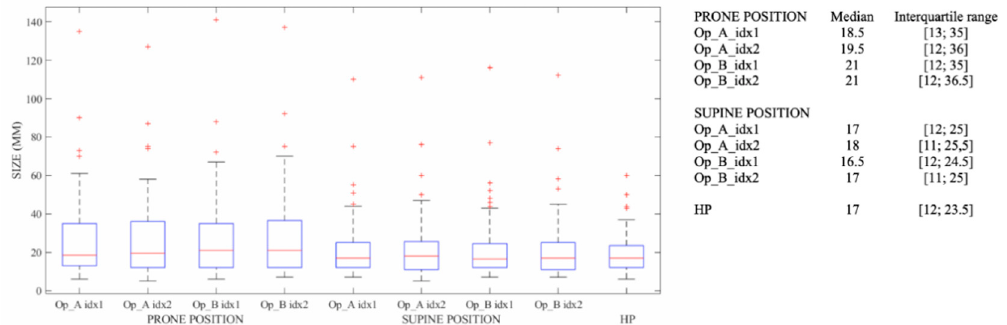
Figure 2. Measurements of the index of the lesion dimension with MRI in the prone position and in the supine position and the lesion dimensions detected by histopathology. Table 3. p -values of lesion dimensions. ( a ) Intraobserver Test; ( b ) Interobserver Test; ( c ) Test P vs. S; ( d ) Test idx1–2 vs. HP.